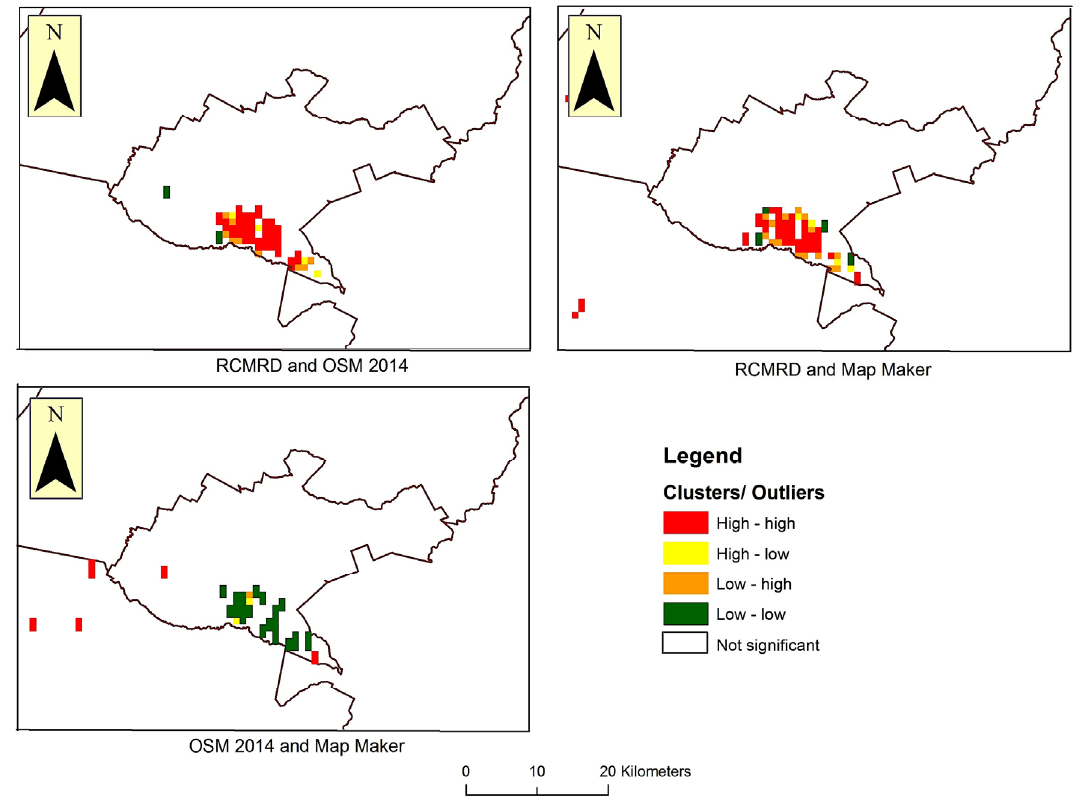
Figure 12. Cluster/outliers between road networks normalized by population.